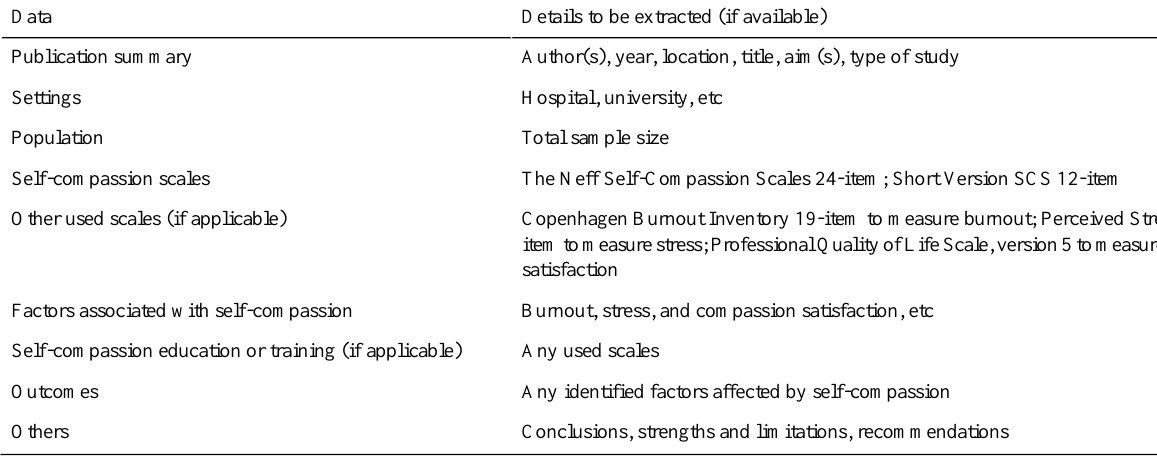
Table 2. Relevant studies.